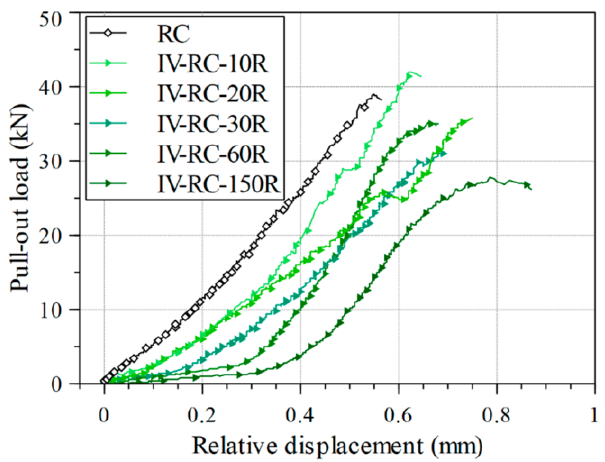
Figure 16. Pullout load versus steel bar relative displacement during pullout test.